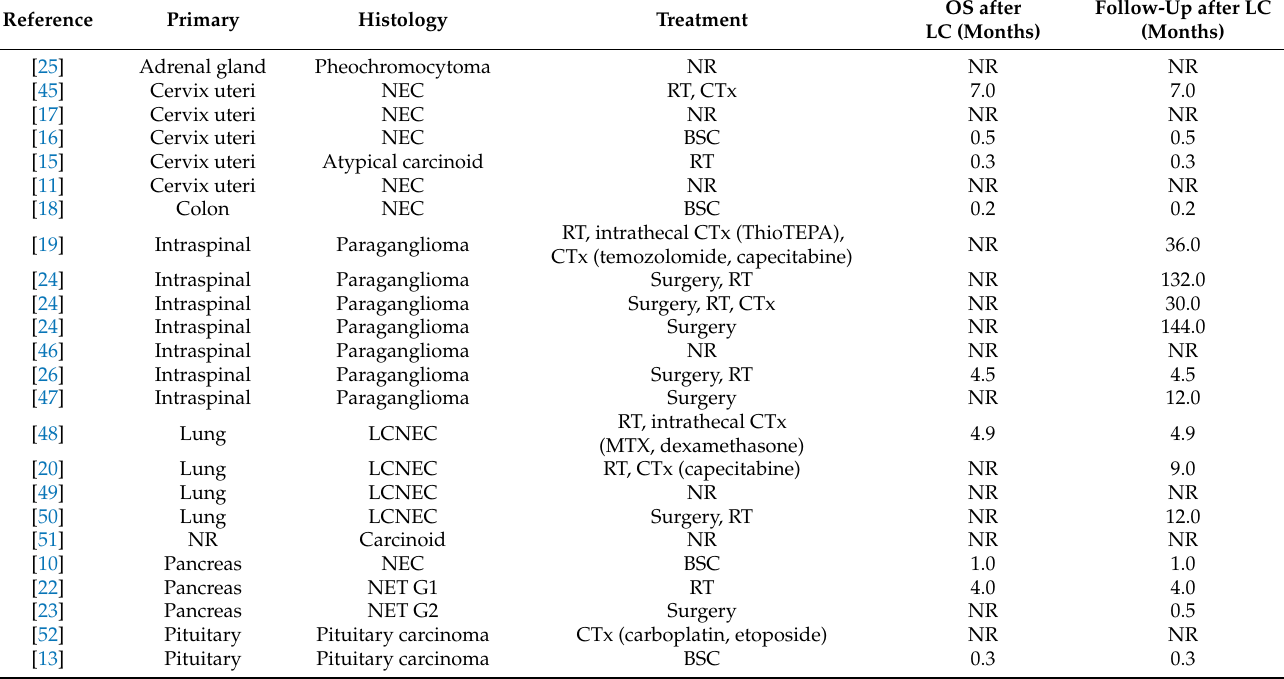
Table 3. Summary of previously reported non-SCLC NEN patients with leptomeningeal carcinomatosis.